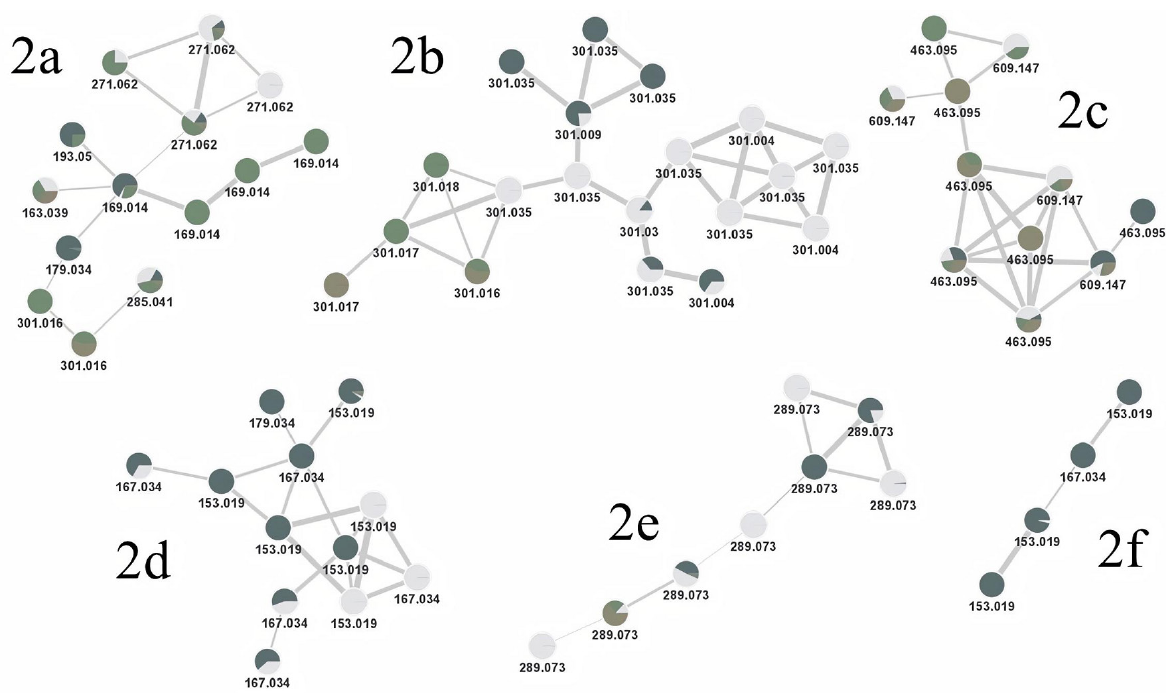
Figure 2. Full classical molecular network realized using MS/MS data and visualized in Cytoscape from the ethanolic extracts of flowers (EEF), leaves (EEL), and sub-fractions obtained from EEF of B. laevifolia